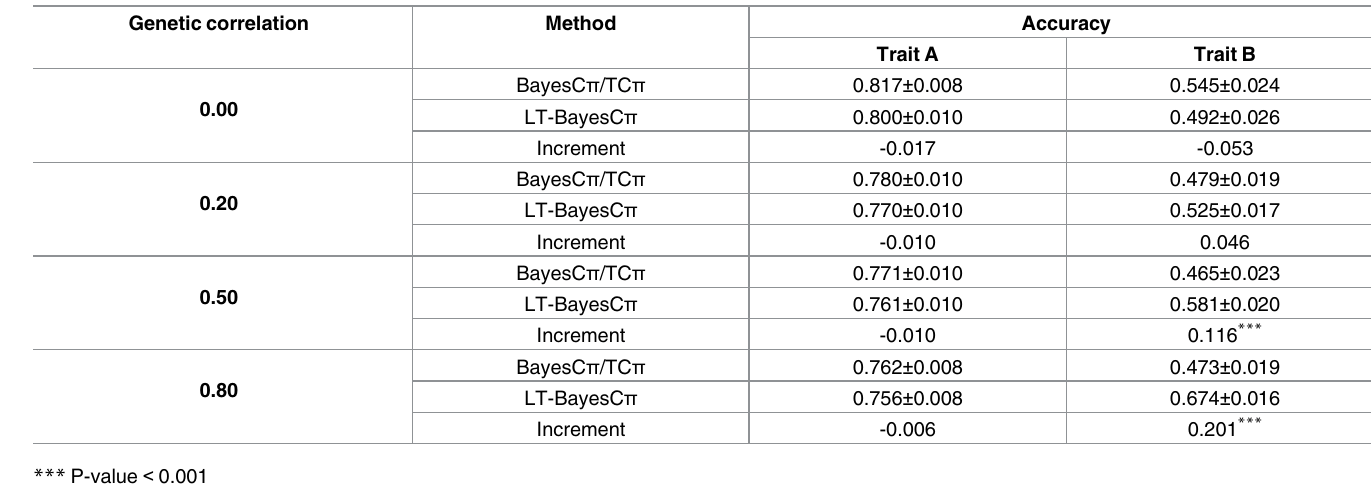
Table 2. Accuracies of GEBVs for the two traits in generation 3 in four scenarios of different genetic correlations. Genetic